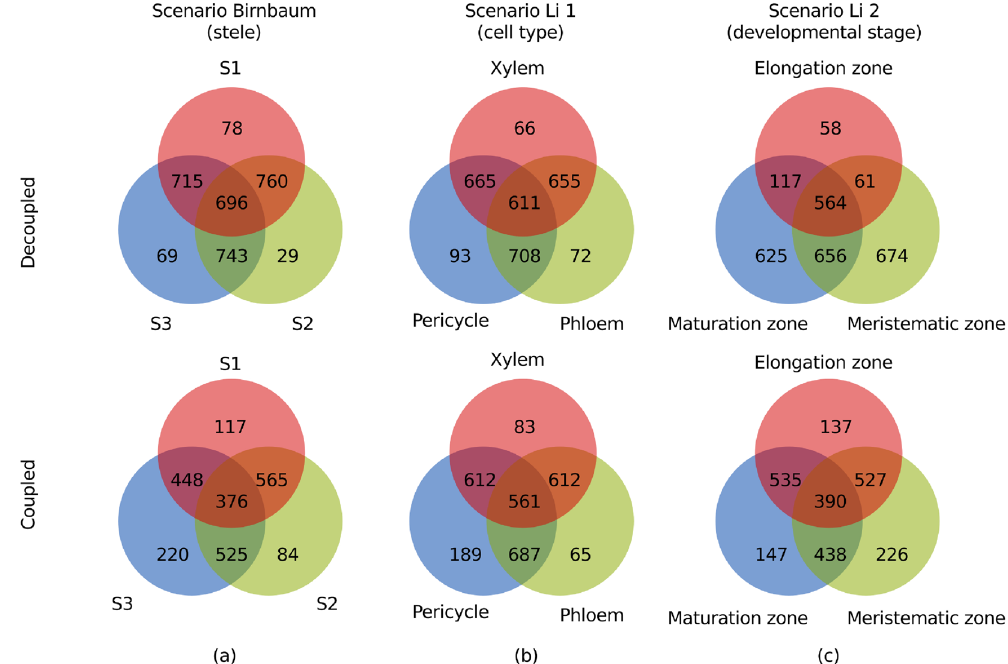
Figure 5. Context-specific reactions and reactions shared across contexts. Venn diagram of pairwise shared, individual reactions and reactions that are shared by all for three scenarios ( a ) scenario Birnbaum (only transcriptomics data from Birnbaum et al . are used) and the stele context only. S1, S2, S3 refer to developmental stage 1, 2 and 3, respectively, that is equivalent to meristematic, elongation and maturation zone, ( b ) scenario Li 1 in which transcriptomics data for different cell types from Li et al . were considered and ( c ) scenario Li 2 in which the gene expression data for three developmental stages were considered.